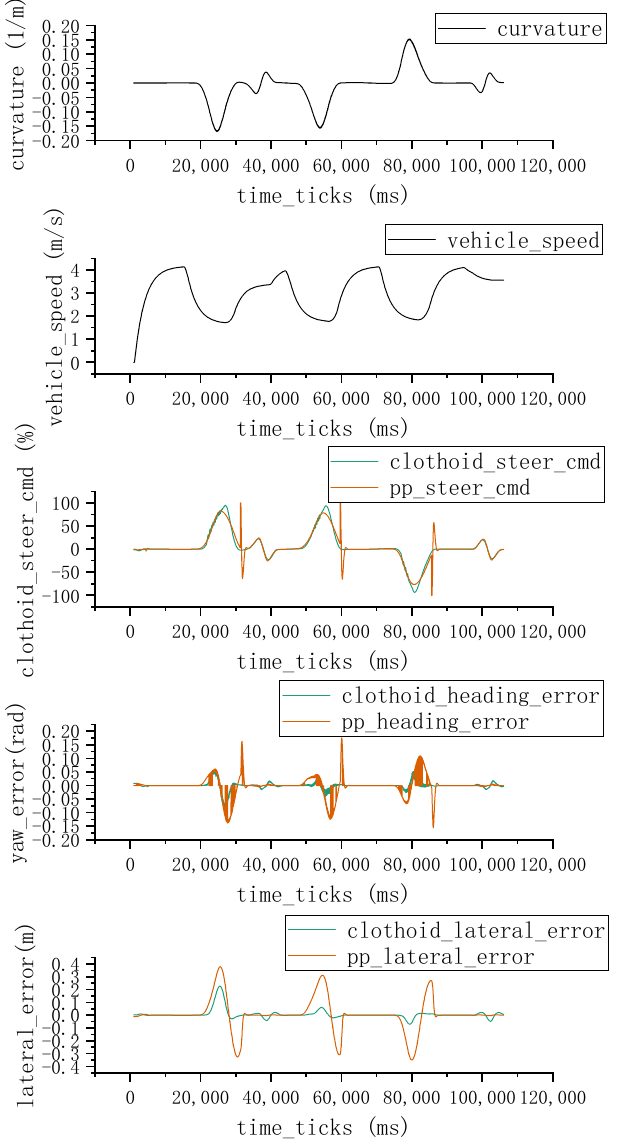
Figure 9. Speed limit 15 km/h trajectory tracking. Top first row: the curvatures along the field test road. Second row: actual speed of the vehicle during the trajectory tracking experiment under the speed limit of 15 km/h. It can be seen that the vehicle will slow down according to the curvature of the road ahead before entering the curve. Third row: steering wheel angle commands the comparison between the pure pursuit method and the method proposed in this paper. It is noted that the steering wheel angle control commands given by the pure pursuit method suffer a drastic oscillation when leaving the right-angle turn, which does not occur in the previous test with a speed limit of 10 km/h. This problem might be caused by the improper selection of the preview distance. Fourth row: yaw angle deviation from the reference path point. The direction deviation generated by the pure pursuit tracking method when leaving the right-angle turn is actually caused by the violent oscillation of the steering wheel angle control command. Last row: lateral deviation from the reference path. Compared with the 10 km/h speed limit test, the tracking deviation of the method proposed in this paper in the first right-angle turn increased, which indicates a limitation that the trajectory tracking accuracy of the method proposed in this paper is sensitive to speed changes when passing the curve with a large